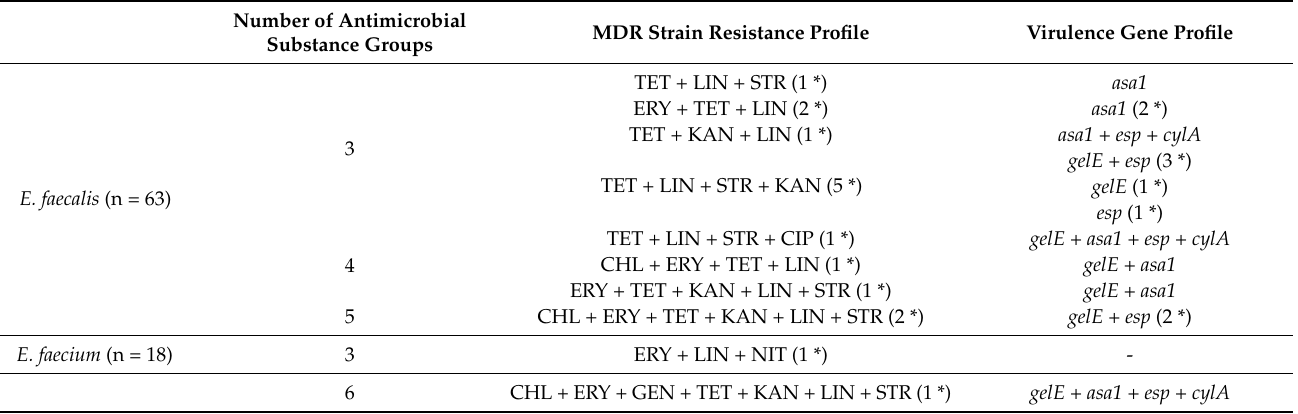
Table 5. Virulence genes patterns in Enterococcus faecalis and Enterococcus faecium multidrug-resistant (MDR)